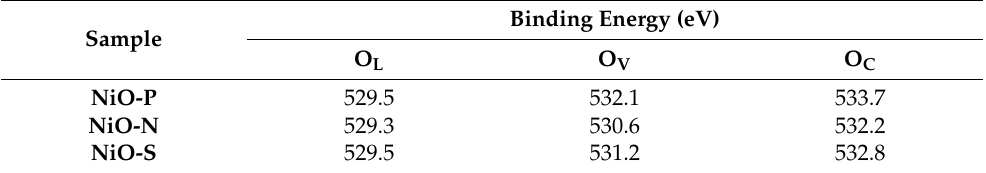
Table 2. The Ni 2p binding energy of NiO-P, NiO-N, and NiO-S. Sample NiO-P